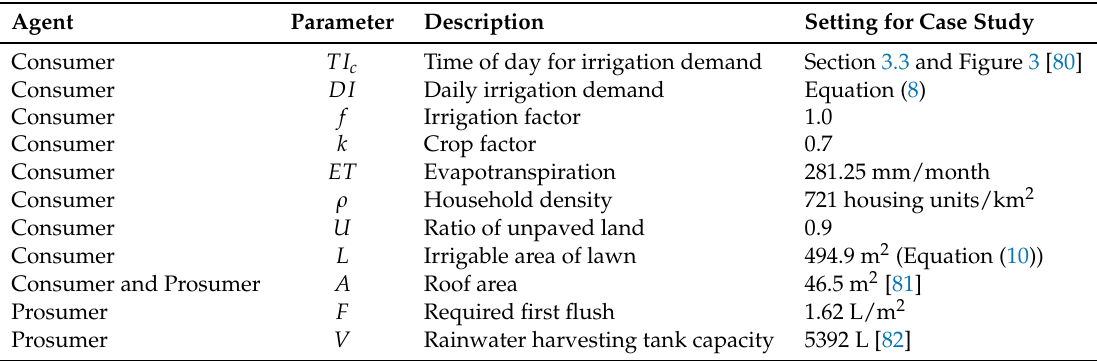
Table 1. Parameters for consumer and prosumer